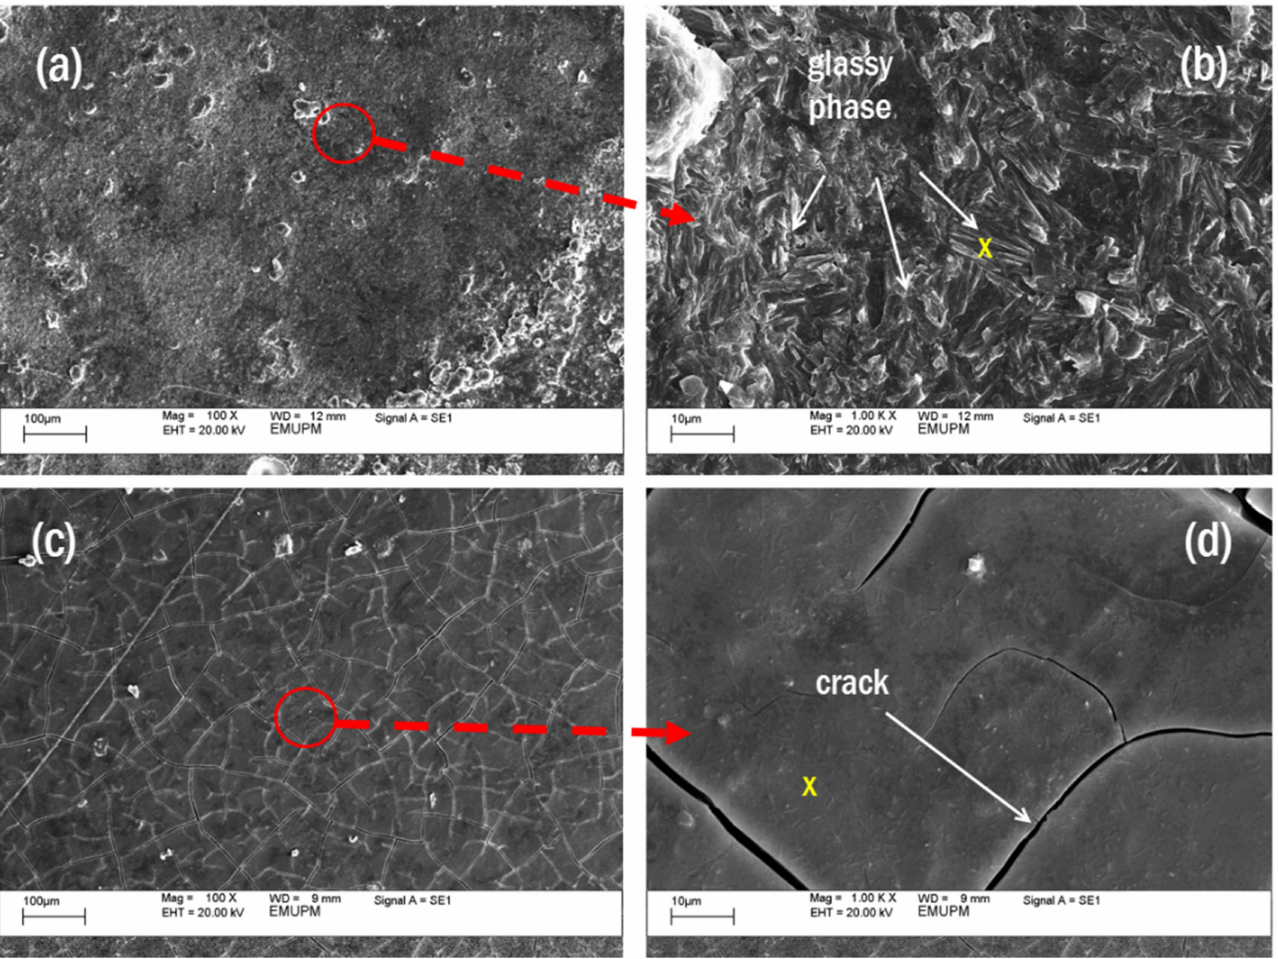
Figure 15. Thermal images of samples S7 ( a , b ) and S5 ( c , d ) in fire-retardant test. All results were presented in weight percent (wt.%). The results showed that the glassy phase in sample S7 was not due to an excess of sodium (Na) or silica (Si) but a good mix of the two components since the difference in wt.% between Na and Si was small, which was only 6.76%. This glassy phase was, thus, the result of a high degree of crystallinity, as indicated by the high peak intensity shown in Figure 14. Other elements found in sample S7 included oxygen and